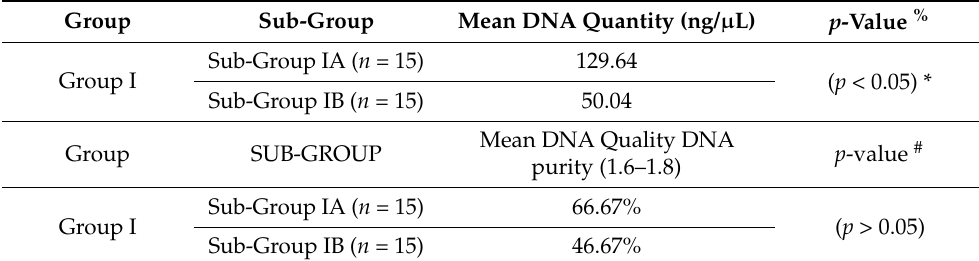
Table 4. DNA quantity and quality obtained across the deparaffinizing methods.